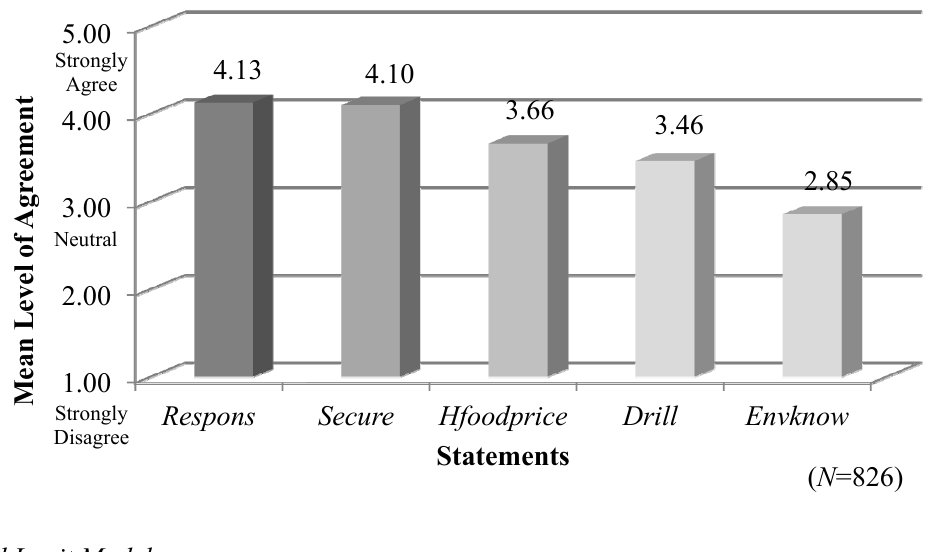
Figure 1. Mean level of agreement with statements about fuel and food security and the